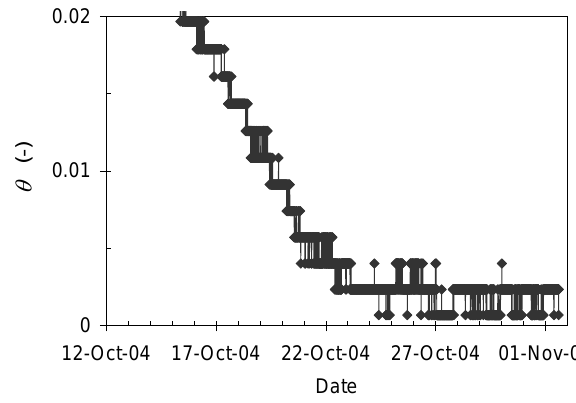
Fig. 6. Volumetric moisture content θ measurements in dry soil by Figure 6. Volumetric moisture content θ measurements in dry soil by one of the time 560 one of the time domain reflectometers (TDR1) installed in evapora- domain reflectometers (TDR1) installed in evaporation container 1 (EB1). 561 tion container 1 (EB1).